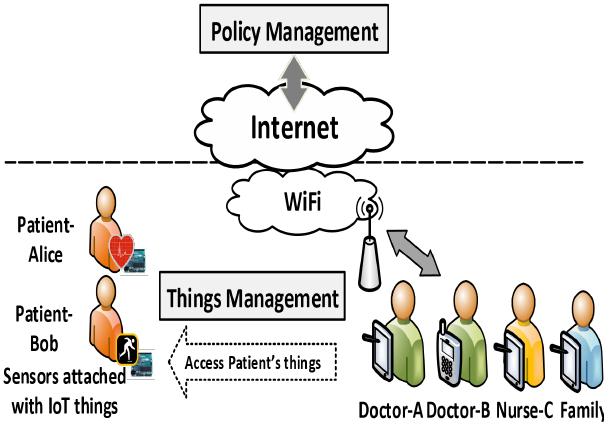
Figure 2. Our use-case scenario. The ‘Policy Management’ moduleholds policies that allow a user (e.g. doctor, nurse or family)access to the IoT ‘things’ associated with a particular patient. The ‘Things Management’ modulemanagesthe access controlof each